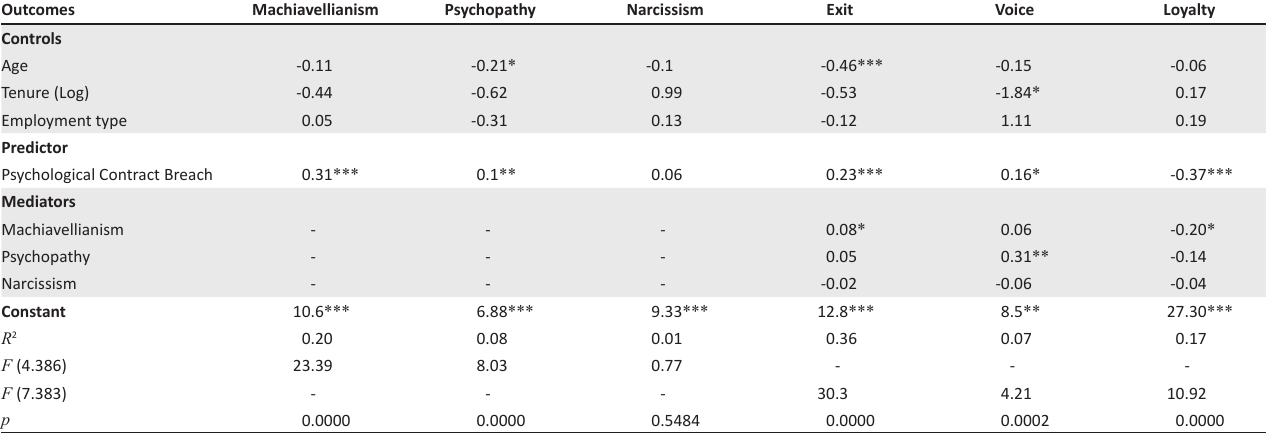
TABLE 3: Results from test of